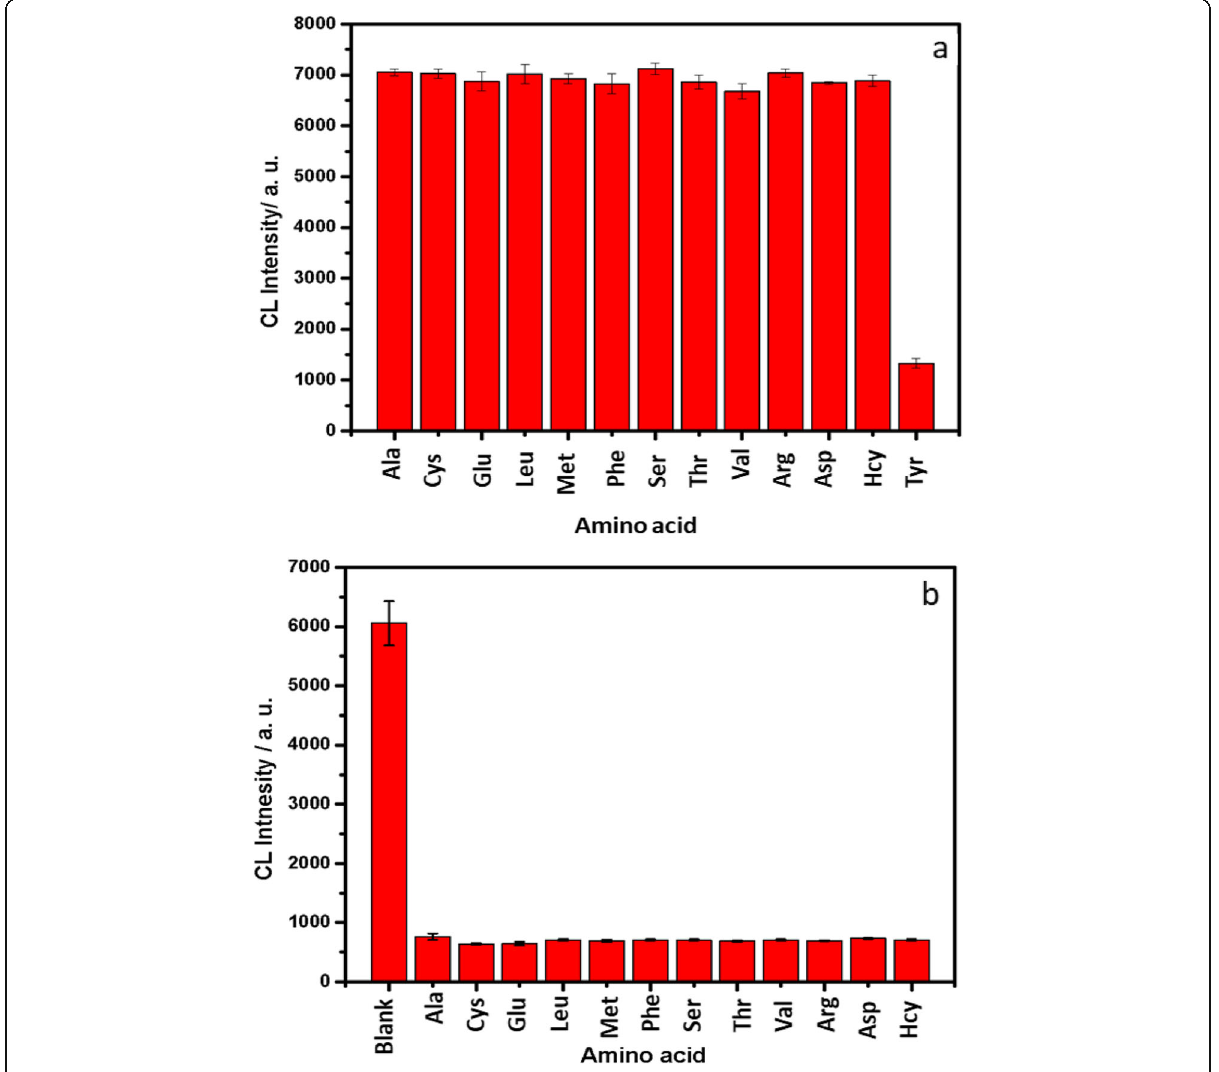
Fig. 5 Selectivity of the CL system for detecting Tyr ( a ) and anti-interference of Tyr ( b ) Experimental conditions: c(amino acids)=0.03 mmol/L, c(Tyr)=0.001 mmol/L, c(BR)=0.018 mmol/L at pH 7.8, c(sodium fluorescein)=0.701 mmol/L, c(ABEI)=0.037 mmol/L, c(H 2 O 2 )=0.014 mol/L, c(HRP)=0.098